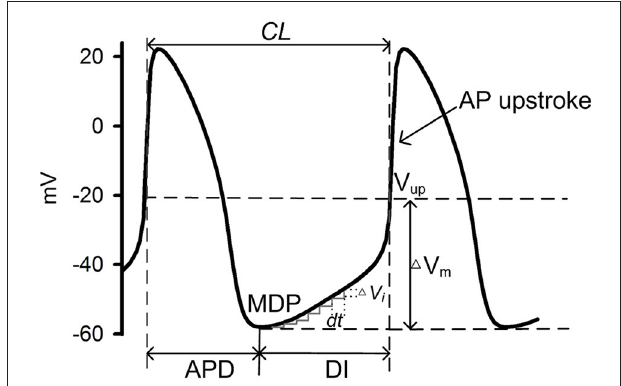
FIGURE 2 | Schematic illustration of a cycle of SAN cell action potentials. During one cycle, the time interval between two consecutive action potentials measures the intrinsic pacemaking CL, which can be considered as a sum of the AP duration (APD) and the diastolic interval (DI) which starts from the maximum diastolic potential (MDP) to the beginning of AP upstroke [V up ( Fabbri et al., 2017)]. 1 V m denotes the voltage difference between the MPD and the V up . During the DI, multiple time intervals (d t ) were needed for the membrane potential to transit from the MDP to the V up , during each of which a 1 V i is